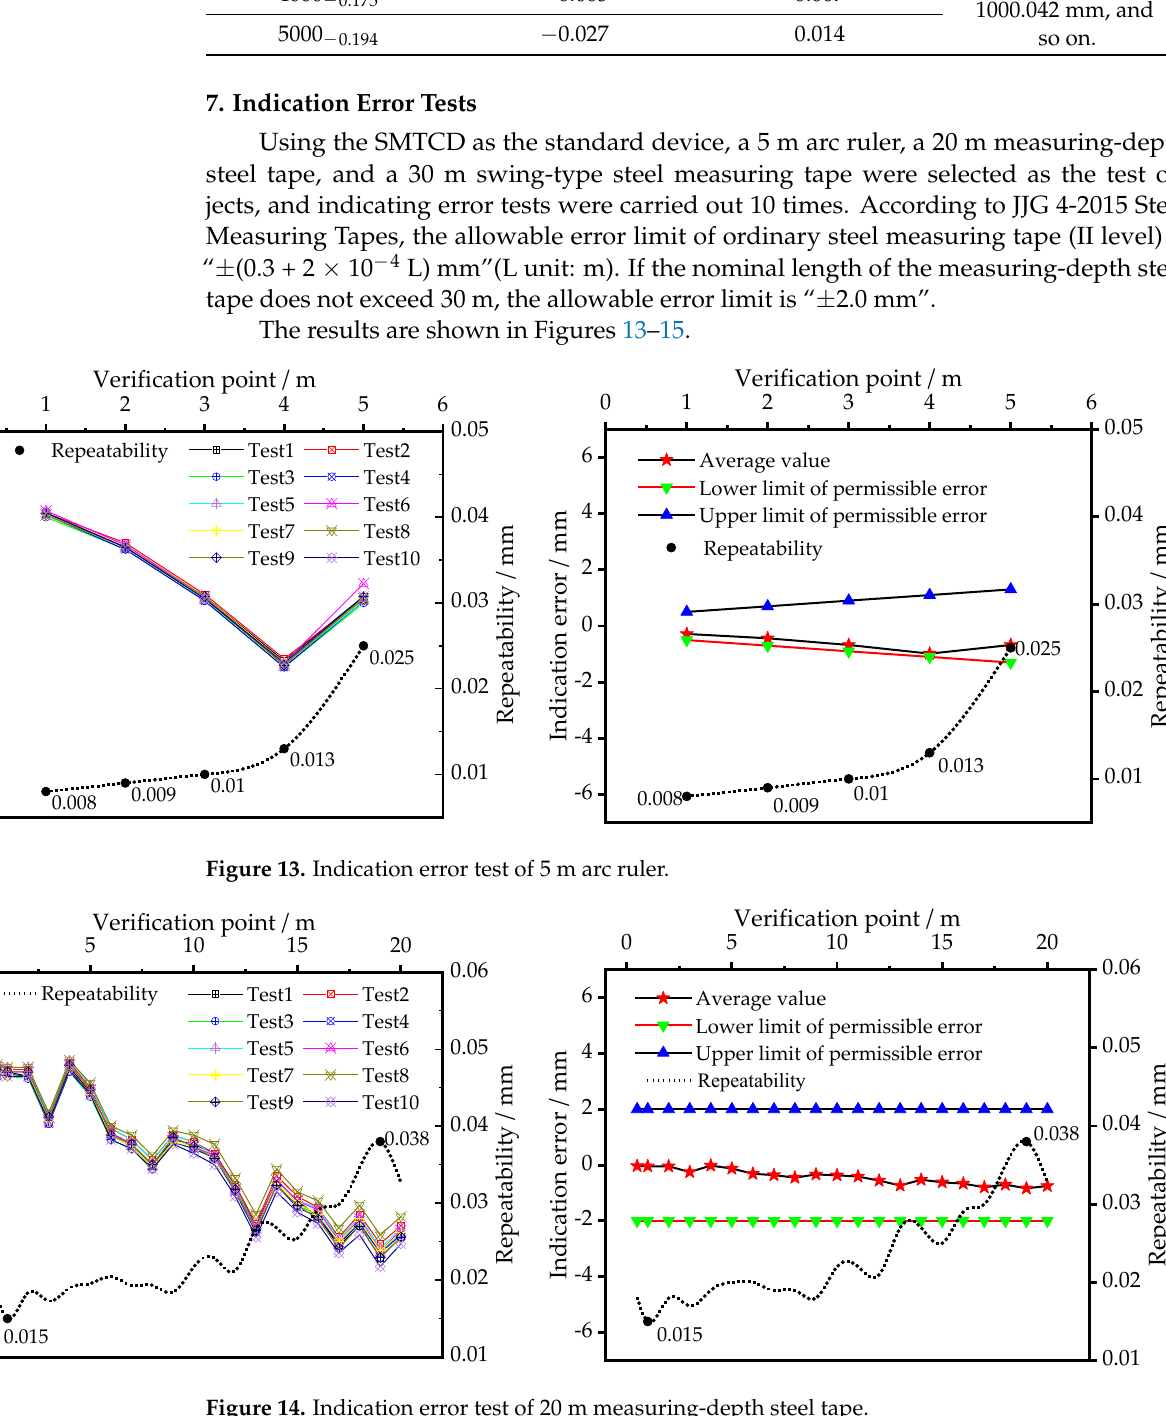
Figure 14. Indication error test of 20 m measuring-depth steel tape.